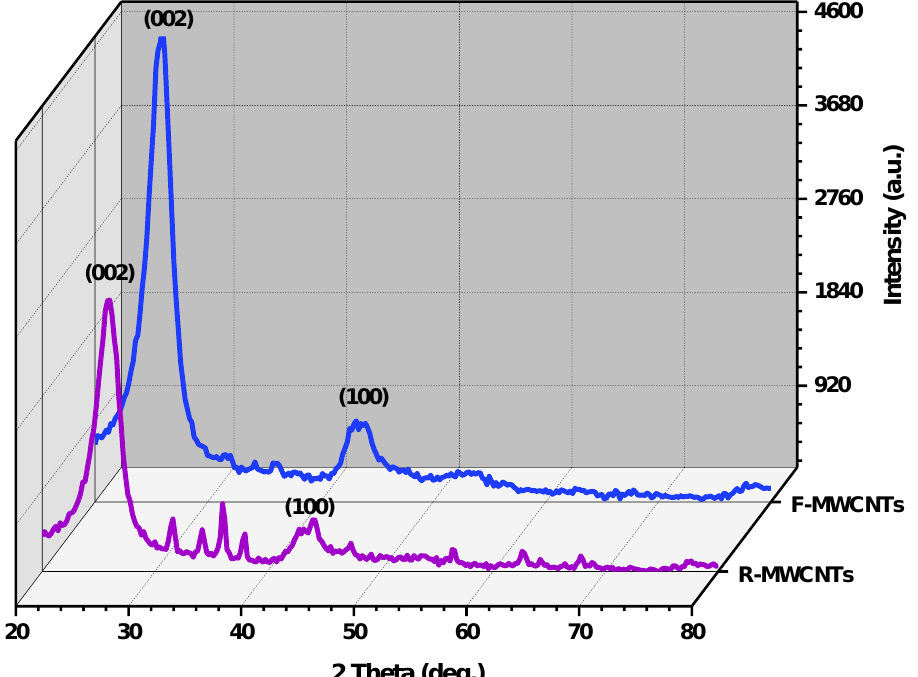
Figure 2: XRD patterns for R-MWCNTs and F-MWCNTs